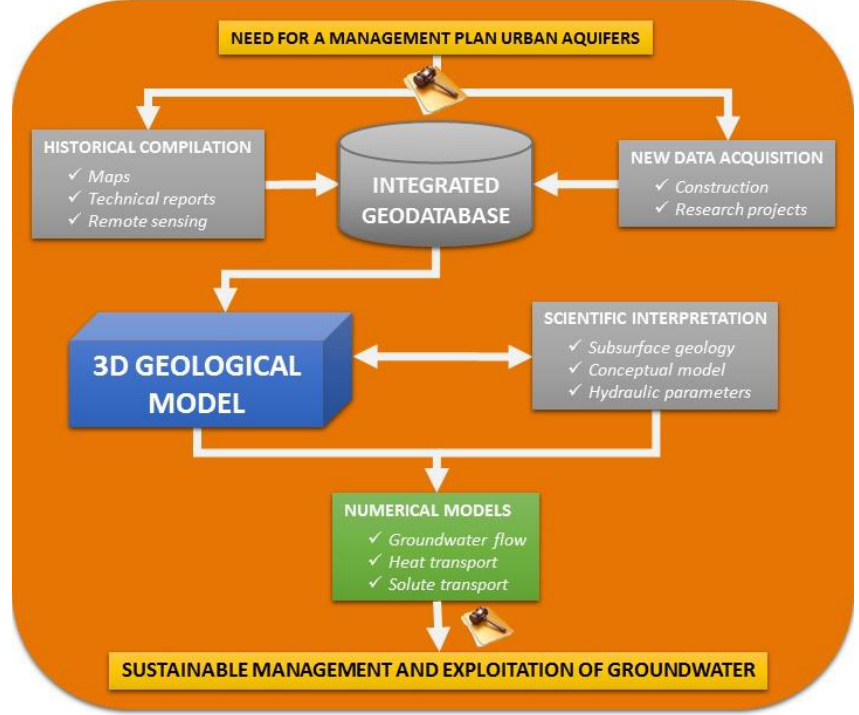
Figure 2. Outline of the methodology proposed for the efficient management of geological and hydrogeological data in an urban environment. The symbol of the folder and hammer refers to the process steps where the administration must